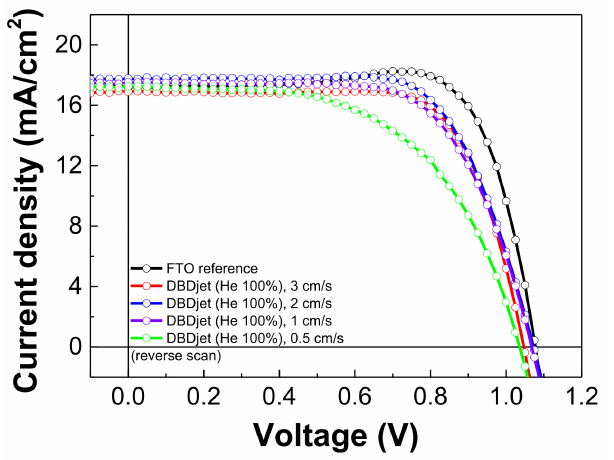
Figure 7. J–V curves of PSCs with He DBDjet treatment on the BCP layer (reverse scan). Table 2. Photovoltaic parameters of PSCs without/with He DBDjet treatment on the BCP layer.